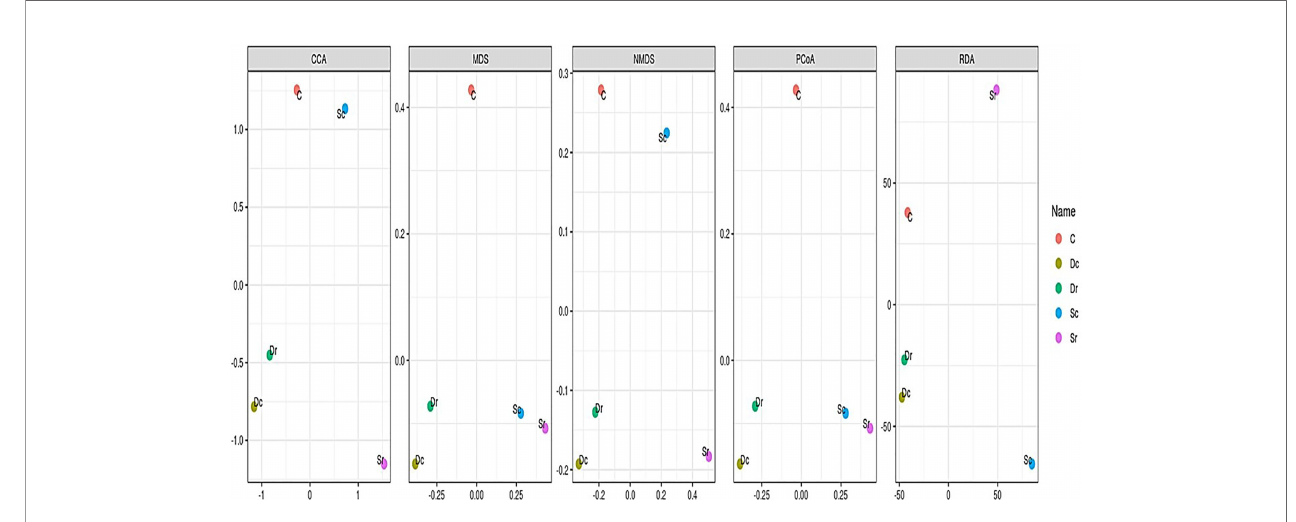
FIGURE 5 | Beta ( b ) diversity indices of soil samples (C, Dc, Dr, Sc, and